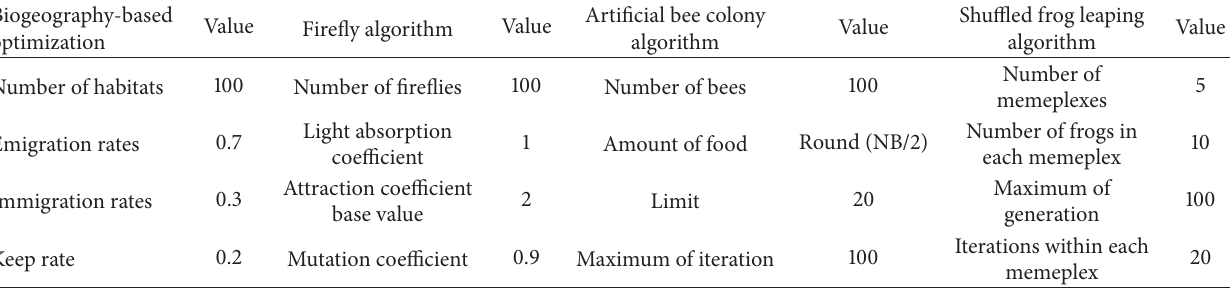
Table 7: The main adjusted parameters in the investigated